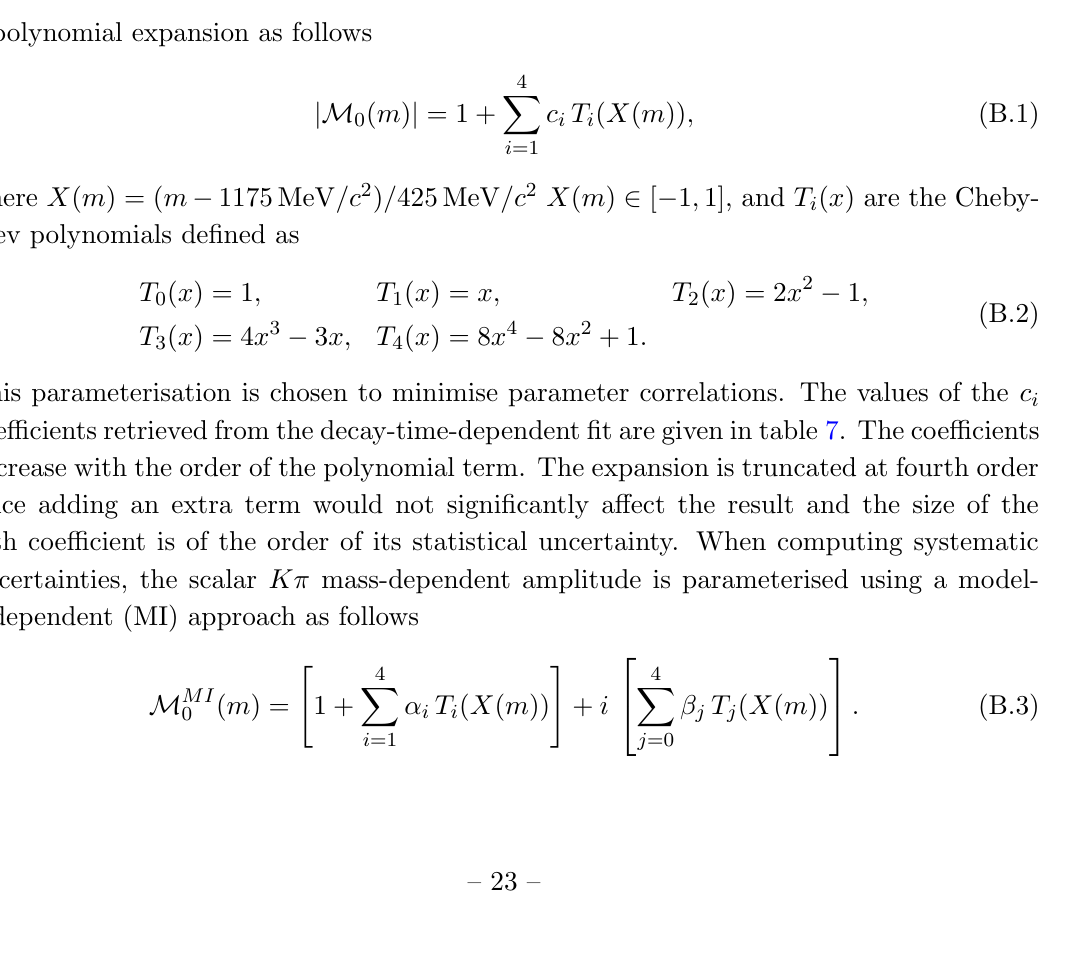
Figure 8 . Line-shapes of the (left) modulus and (right) phase of the scalar K(cid:25) mass-dependent amplitude. The nominal model is shown with a solid blue line and the model-independent param- eterisation, used in systematic studies, is shown with a dashed red